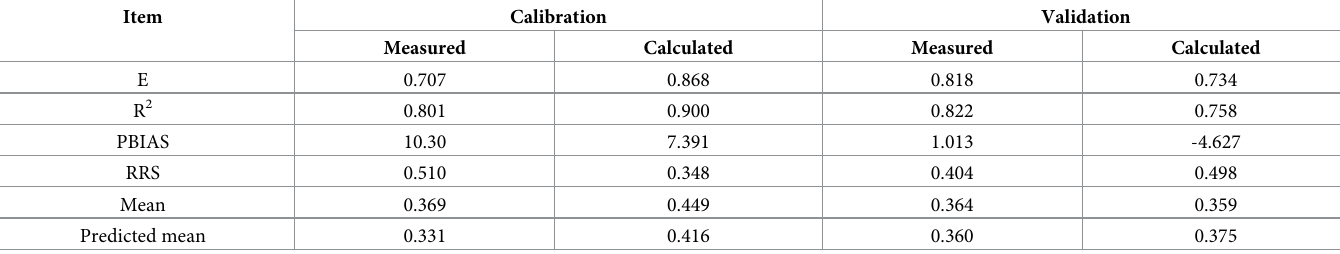
Table 4. Results from the model performance evaluation �